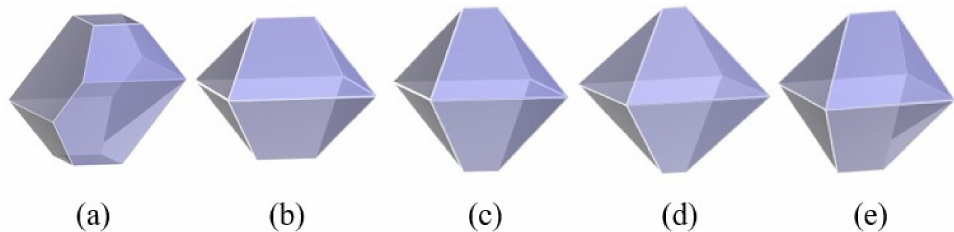
Figure 4. Crystal morphology simulation diagram of β -HMX in DMSO–water system with different mass fractions of water. ( a ) 0%, ( b ) 5%, ( c ) 10%, ( d ) 15%, and ( e ) 20%.